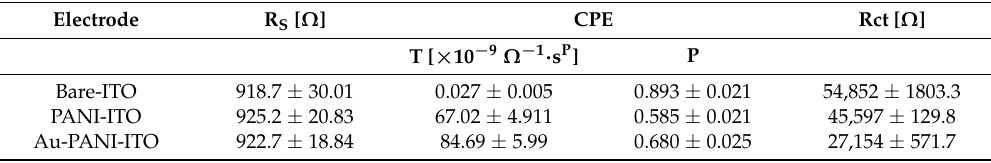
Figure 3. Bode plot shows ( a ) |Z| vs. f and ( b ) Φ vs. f for bare ITO, PANI/ITO, and Au-PANI/ITO electrodes respectively. Inset of figure ( a ) shows the equivalent model circuit used to extrapolate the parameters through impedance fitting analysis. Table 1. Values of the equivalent circuit elements obtained by fitting the experimental results of various electrode modifications for Bode plots represented in Figure 3a and the corresponding relative errors using the equivalent circuit model consisting of the solution resistance (Rs), the constant phase element for the electrode interfacial impedance (CPE) and the charge transfer resistance (Rct).